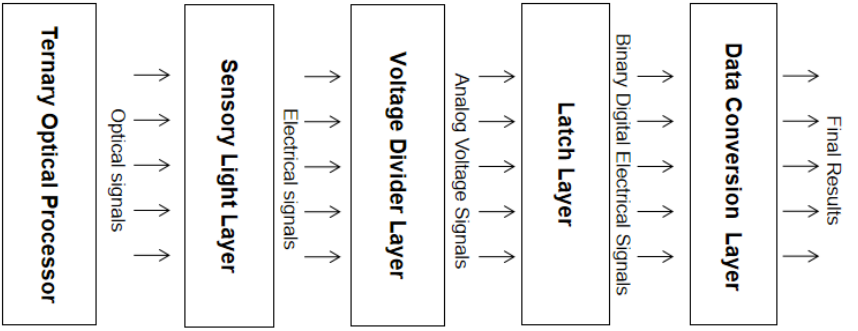
Figure 7. Layered design of the tri-state optical signal detector.